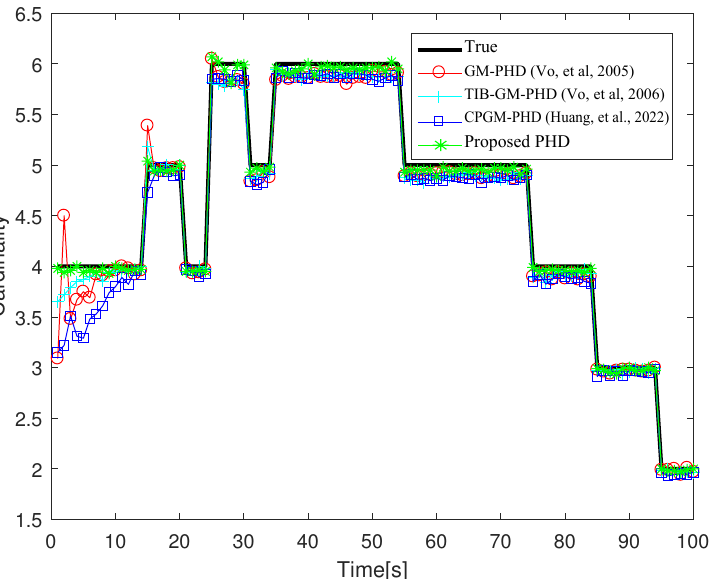
Figure 7. Comparison of cardinality estimates between GM-PHD, TIB-GM-PHD, CPGM-PHD and Proposed PHD (The numbers in brackets represent references to various PHD